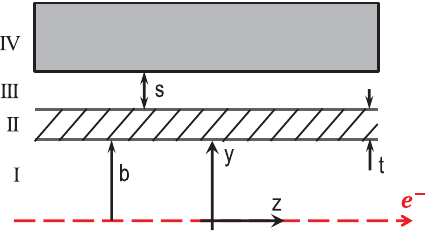
FIG. 5. Geometry of the vacuum chamber in planar